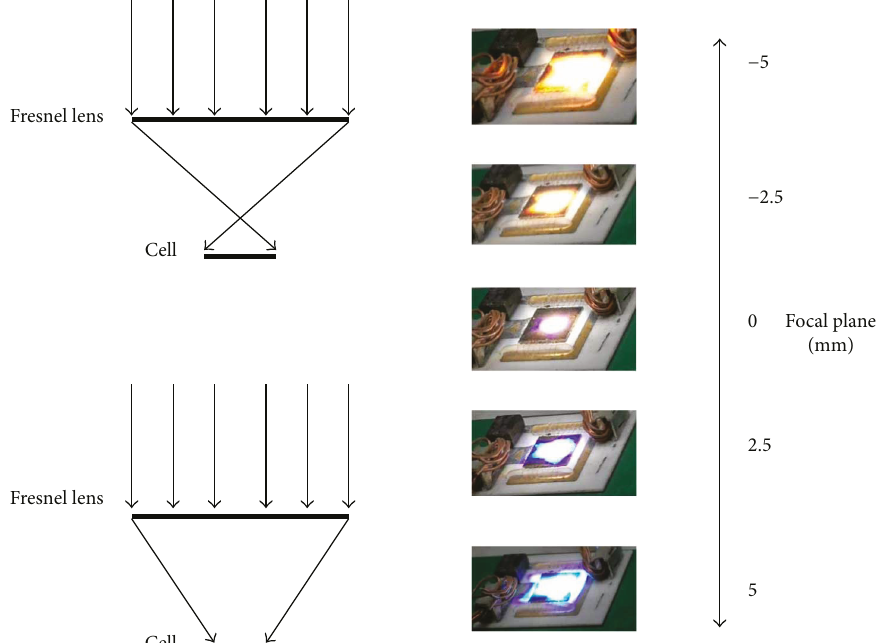
Figure 9: Light spots vary with the installation position of the triple-junction cell (along the direction of the optical